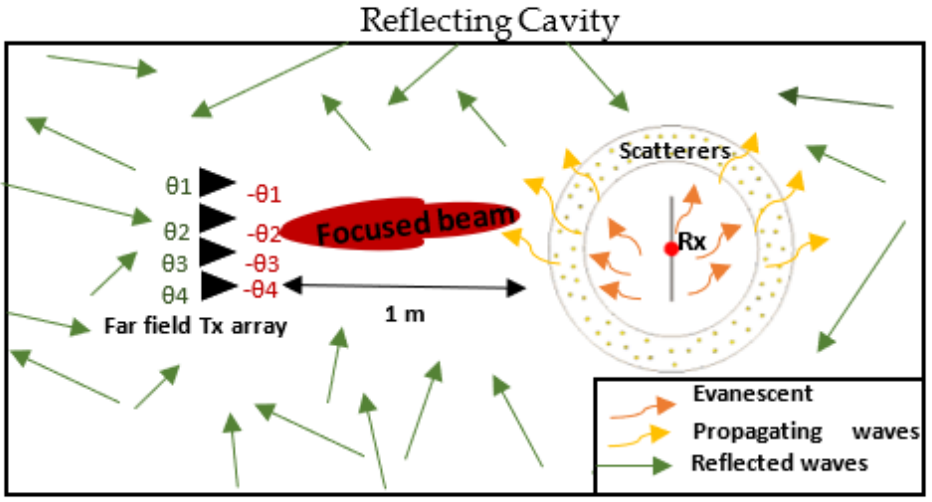
Figure 3. Retrodirective WPT approach in multipath environment in the presence of scatterers in the Rx antenna near field.